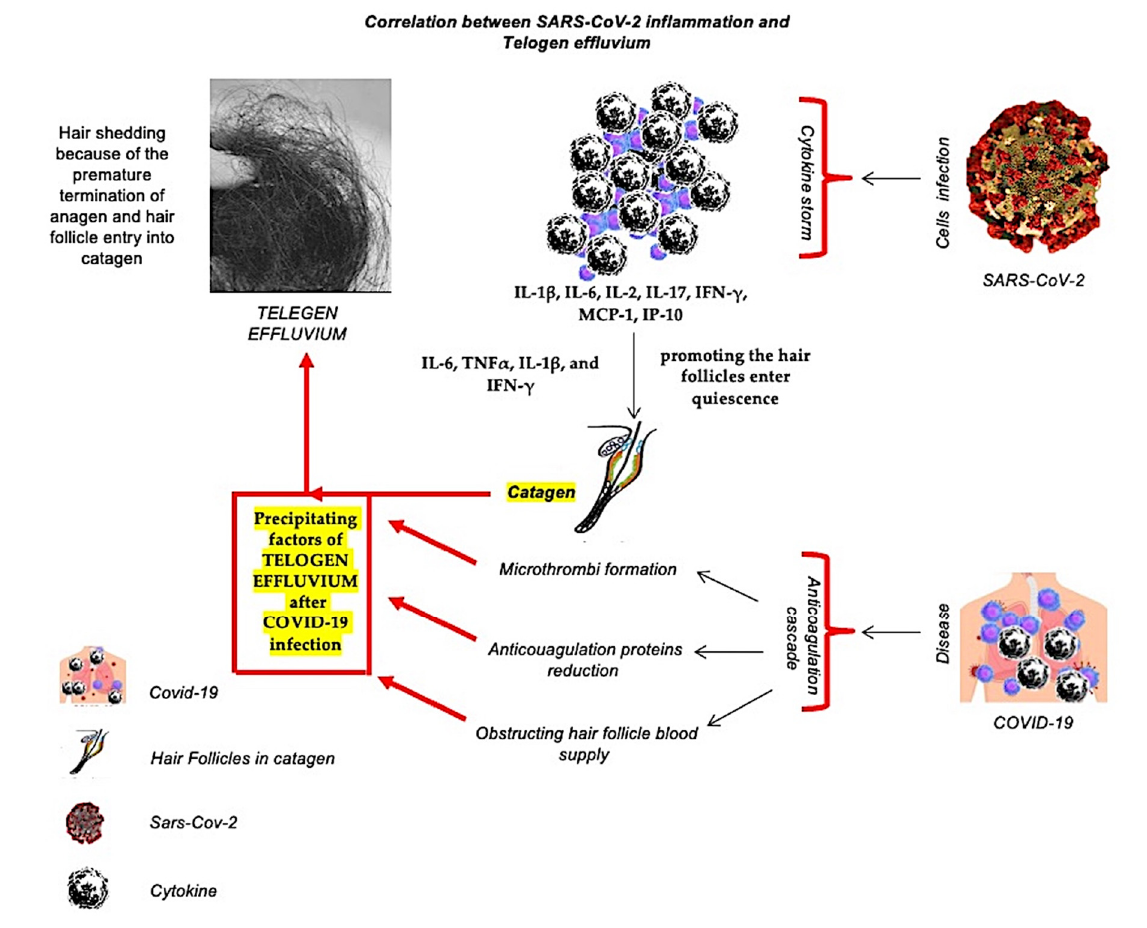
Figure 2. A graphic illustration of the correlation between the inflammation produced by SARS-CoV-2 cell invasion and Covid-19 disease with telogen effluvium.